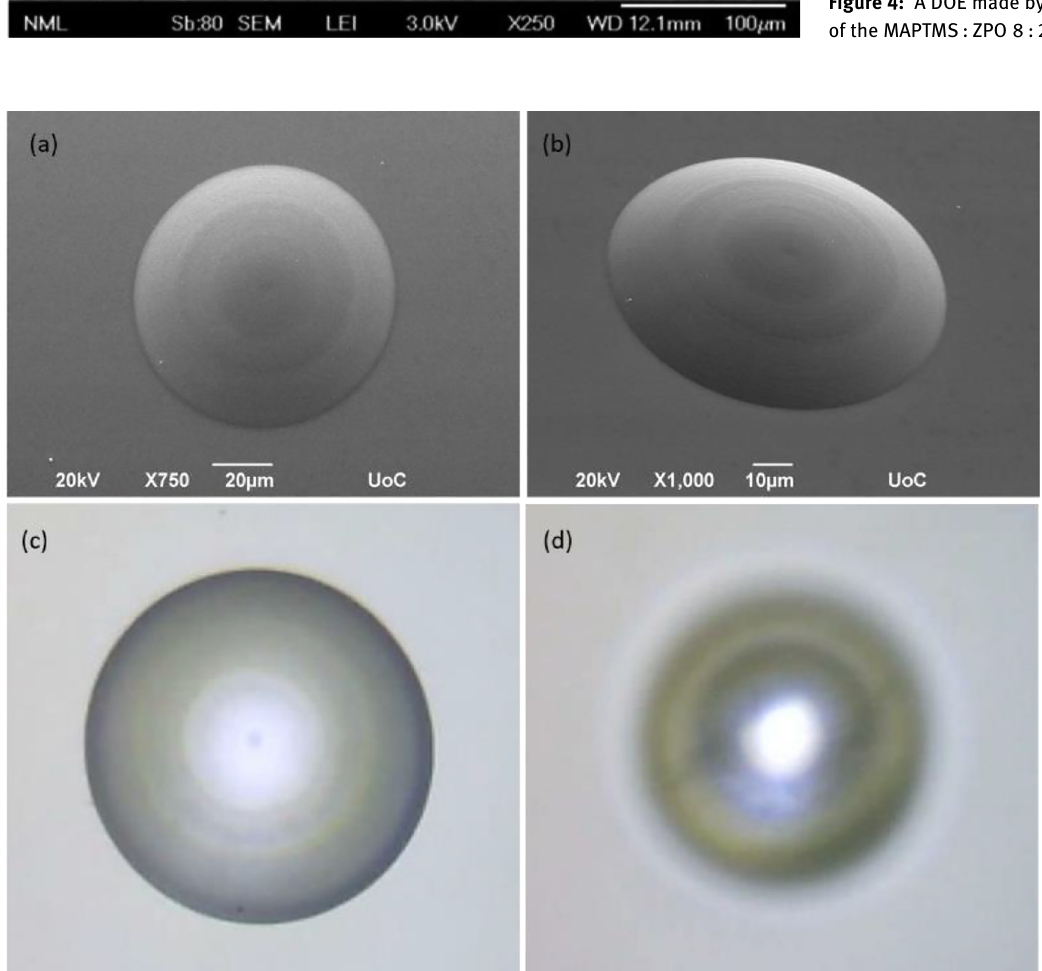
Figure 5: (a) SEM image of a printed microlens using the MPL technique (b) tilted view of the microlens (c) optical microscope image of the samelens(d)opticalmicroscopeimageofthemicrolensfocusingonaplaneabovethelens,wherethefocusingofthetransmittedlightcanbe